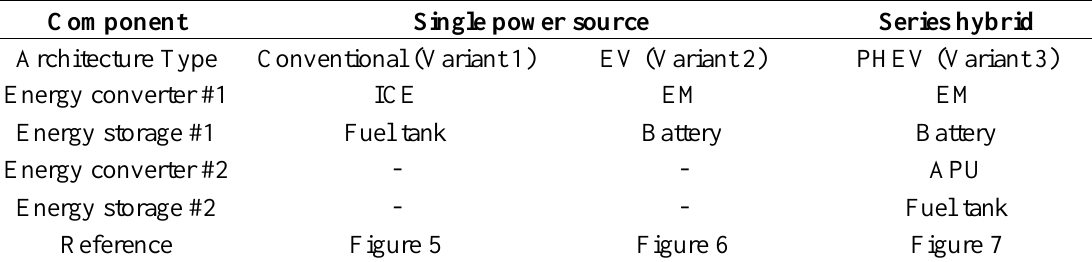
Table 4. Powertrain architectures simulated by model framework.